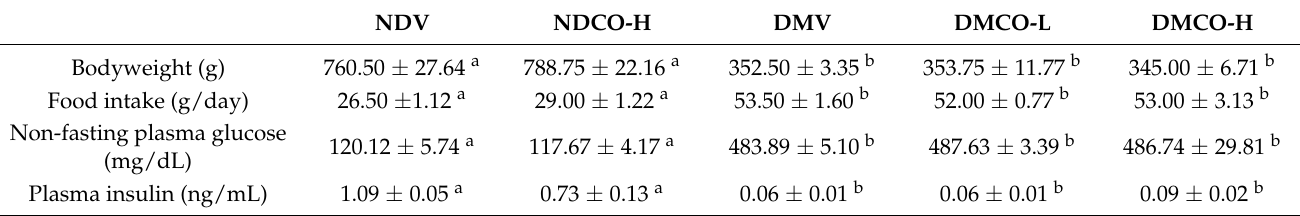
Table 3. Metabolic parameters in all experimental groups at the age of 40 weeks.